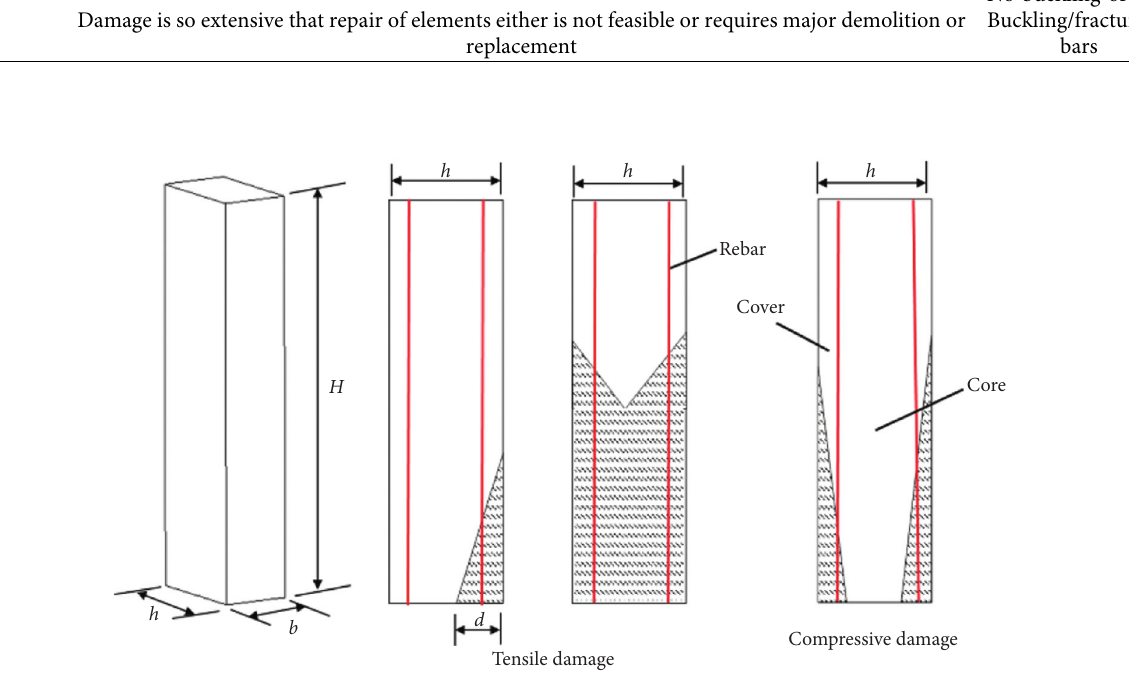
Figure 6: Material damage distribution in column under flexural loads [43]. Table 2: Relationship between damage states, engineering limit states, and material